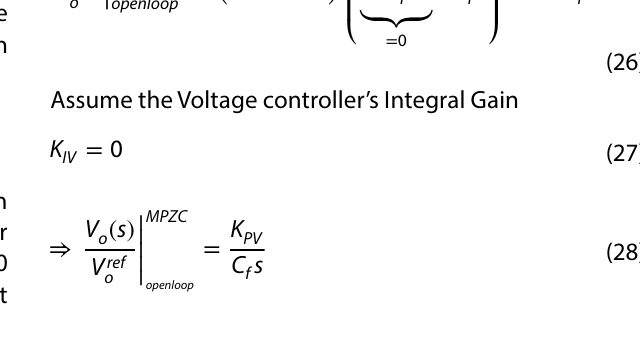
Table 8 Computed parameters of V/I controllers